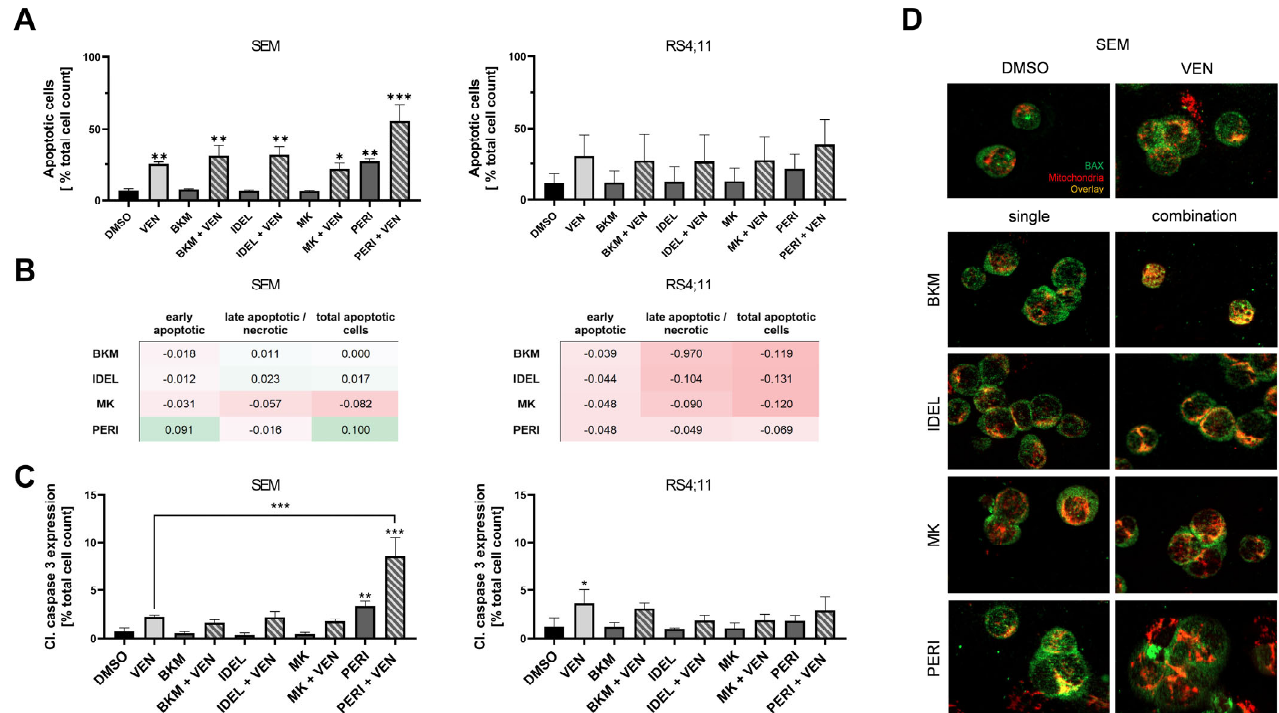
Figure 2. Analysis of apoptotic processes following combined BCL-2 and PI3K/AKT inhibition. ( A ) Flow-cytometric annexin V/PI analysis after 72 h incubation (n ≥ 3; ANOVA and post-hoc Tukey’s multiple comparison test, * p < 0.05, ** p < 0.005, *** p < 0.001). ( B ) Analysis of synergistic apoptosis induction via Bliss independence model using the data presented in ( A ). Values ∆ > 0 resemble synergism (green) while ∆ < 0 implies antagonistic effects (red). ( C ) Detection of activated (cleaved) caspase-3 via intracellular flow cytometry after 48 h incubation (n ≥ 3; ANOVA and post-hoc Tukey’s multiple comparison test, * p < 0.05, ** p < 0.005, *** p < 0.001). ( D ) Immunofluorescence-based BAX translocation assay following 48 h inhibitor incubation. Representative images of at least three independent biological and technical replicates at 400× magnification.